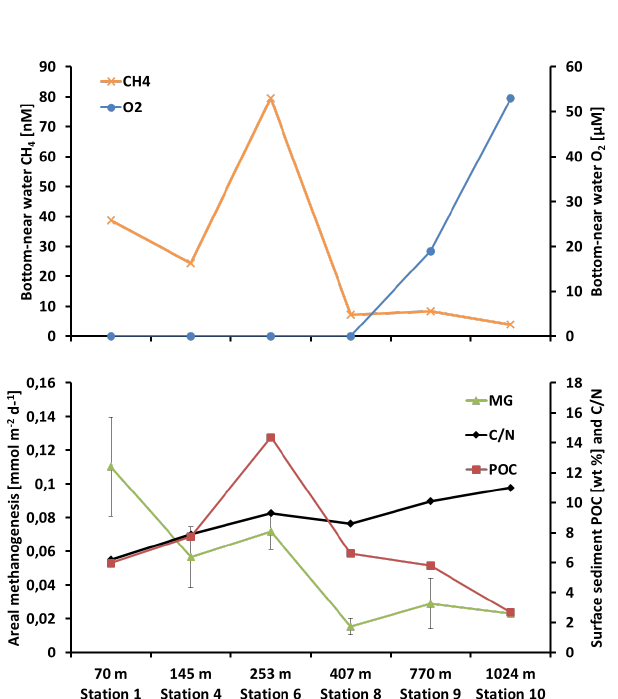
Figure 6. Bottom-near water methane (CH 4 ) and oxygen (O 2 ) con- centrations along the depth transect (above). Surface sediment par- ticulate organic carbon (POC) content and C / N ratio together with integrated methanogenesis (MG) rates (0–25cmb.s.f.) along the depth transect (below). For MG rates, averages are shown with stan- dard deviation beside St. 10, where a mean from two replicates is shown (see text). Please note the secondary y